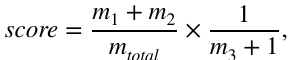
Algorithm 5 introduces how to get the search areas of a trip